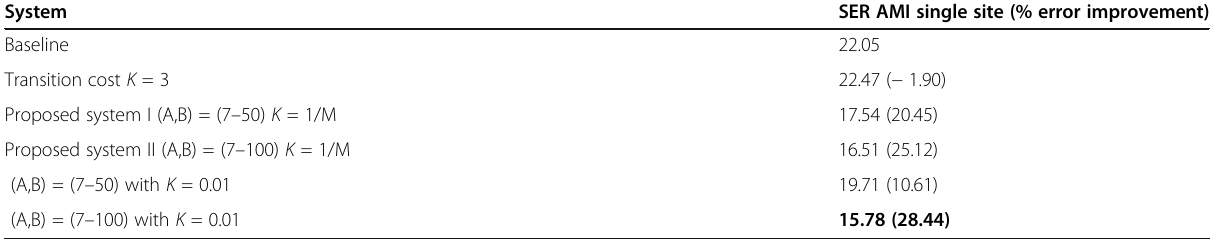
Table 13 Overall results for the AMI single site dataset and the RT09 set for different alternatives